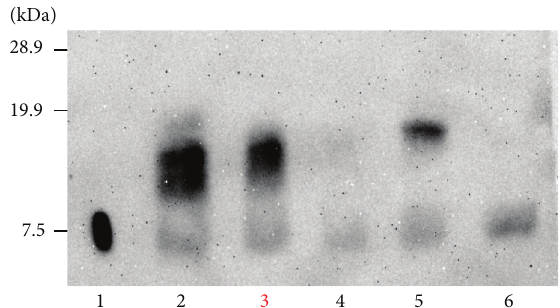
Figure 4: Western immunoblot analysis of serum IGF-II. Patient (Lane 3) and NITCH (Lanes 2 and 5) revealed a high molecular weight form of IGF-II compared with recombinant IGF-II (7.5kDa; Lane 1) or normal (Lane